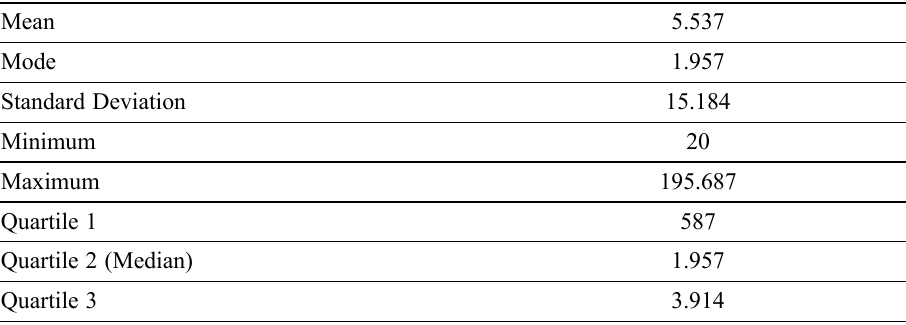
Table 1. Money provided by informal investors (in